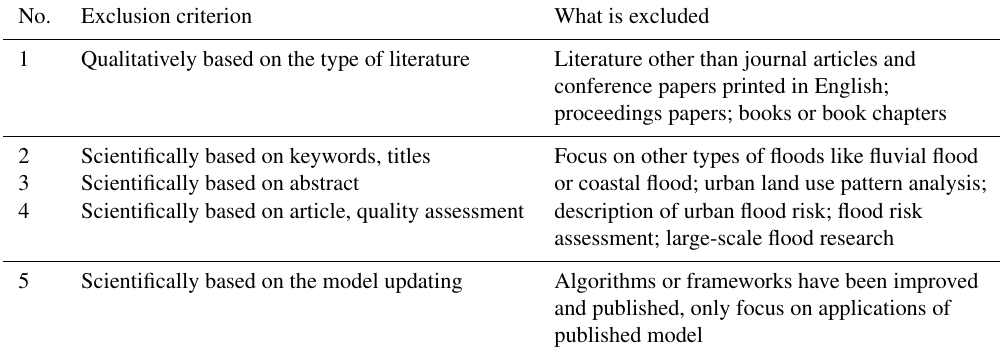
Table 2. Exclusion